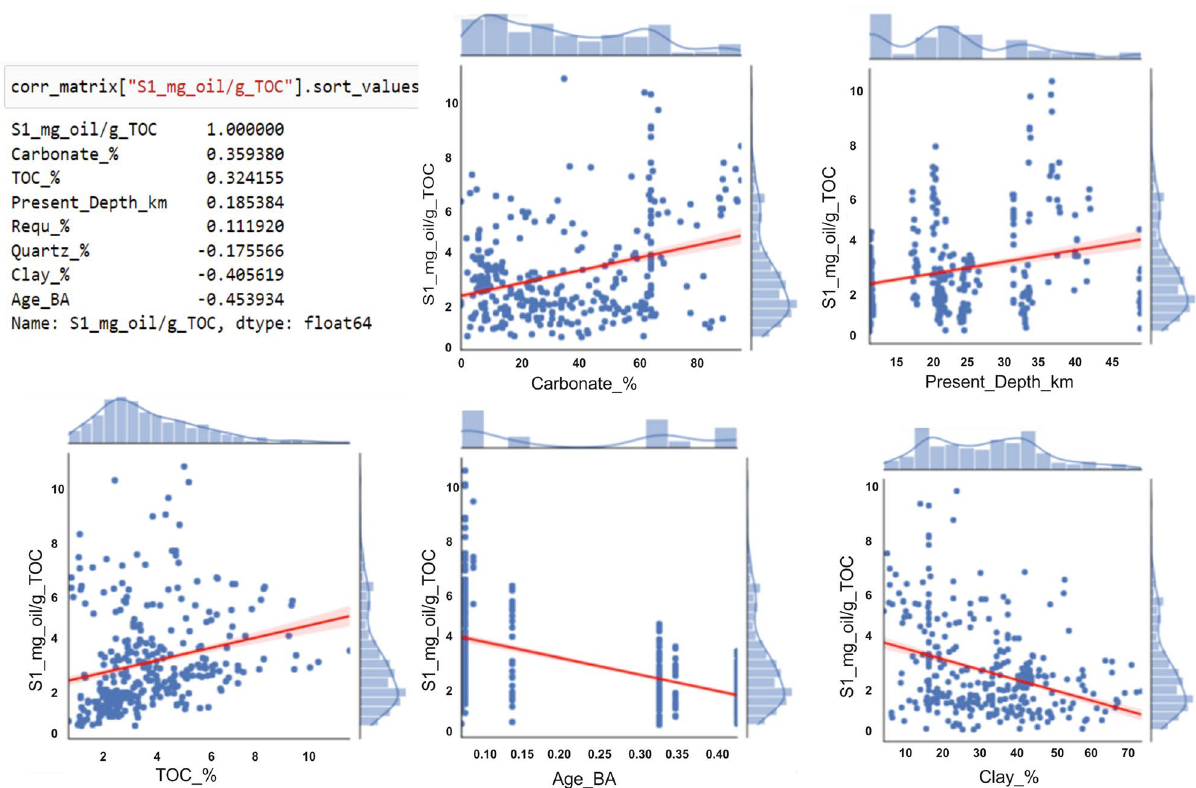
Figure 3. S1 correlation plots of the inputs and target of the training and validation